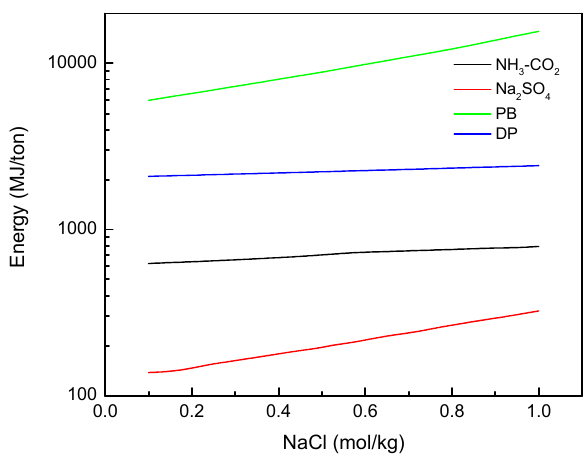
Figure 13. Energy consumption of the FO process using different draw solutes as a function of NaCl concentrations.